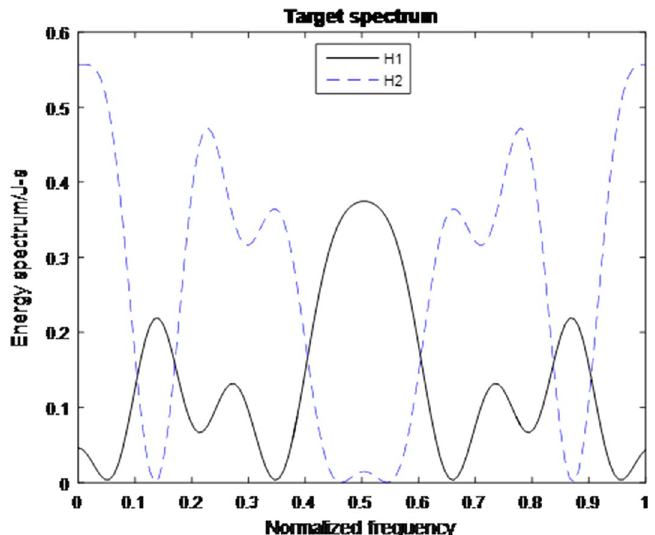
Fig. 4 Energy spectrum allocation of two random targets